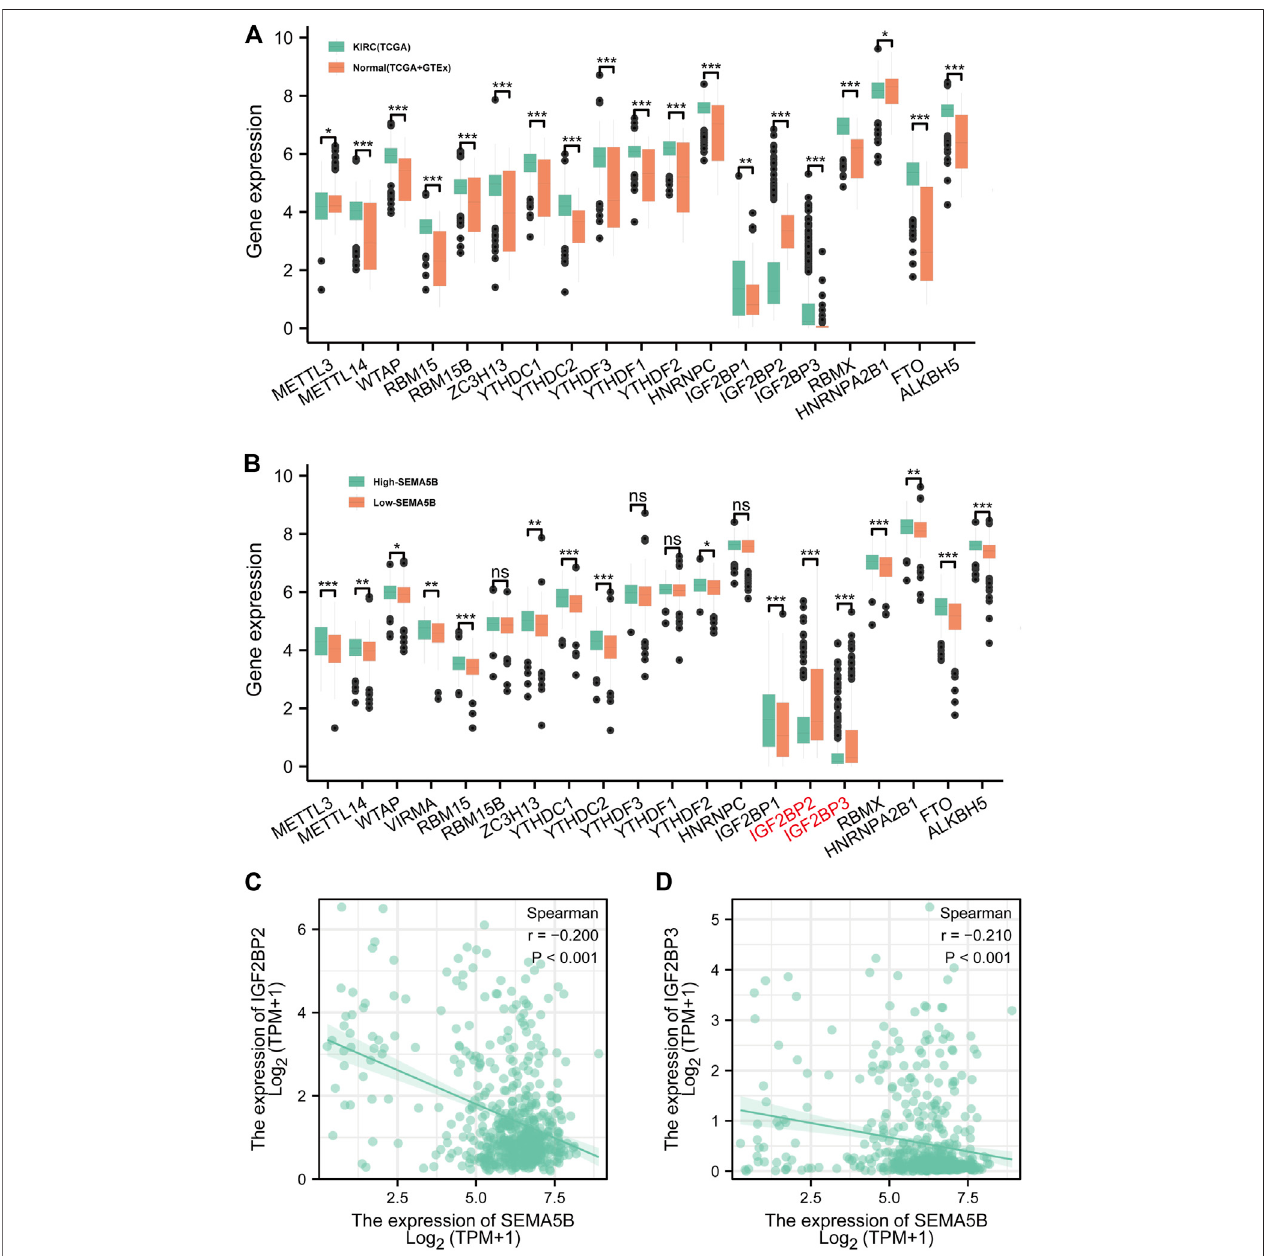
FIGURE 9 | The correlation between the SEMA5B expression and m6A regulators in KIRC. (A) m6A regulators expression between KIRC tissues and normal tissues according to the TCGA and GTEx. (B) m6A regulators expression between high- and low-SEMA5B expression groups of KIRC. Spearman correlation for the relationship between the expression levels of SEMA5B and IGF2BP2 (C) , and IGF2BP3 (D) . ns, p ≥ 0.05; *, p < 0.05; **, p < 0.01; ***, p <